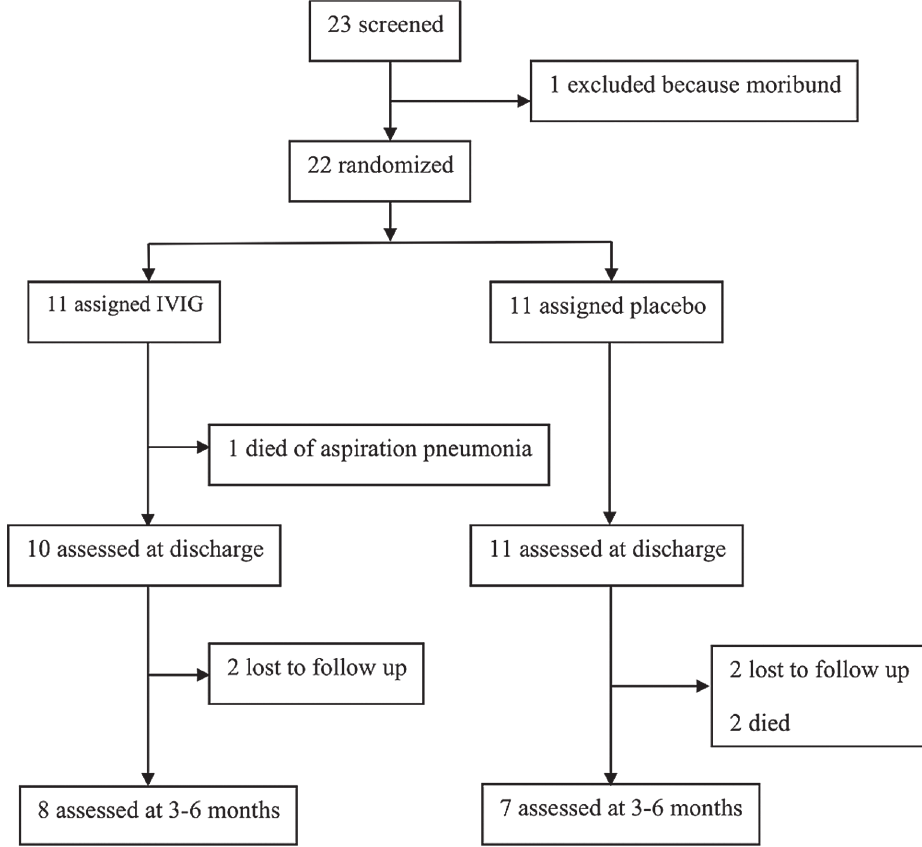
Fig 1. Flow diagram of study participants ’ recruitment and follow-up. All children enrolled, fitting the trial criteria, who were alive at discharge were attempted to be followed-up (n = 21). Twenty-one families were successfully contacted. Among these families, two children had